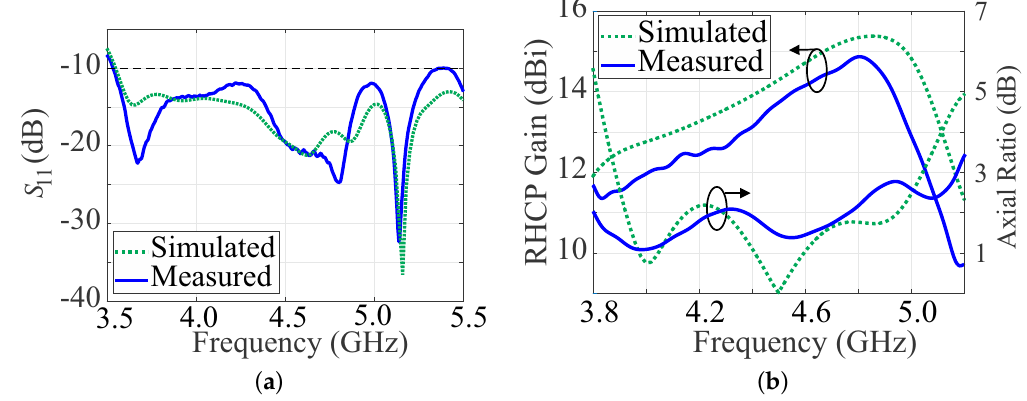
Figure 8. Comparison between simulated and measured values of the ( a ) reflection coefficient, ( b ) RHCP broadside gain, and axial